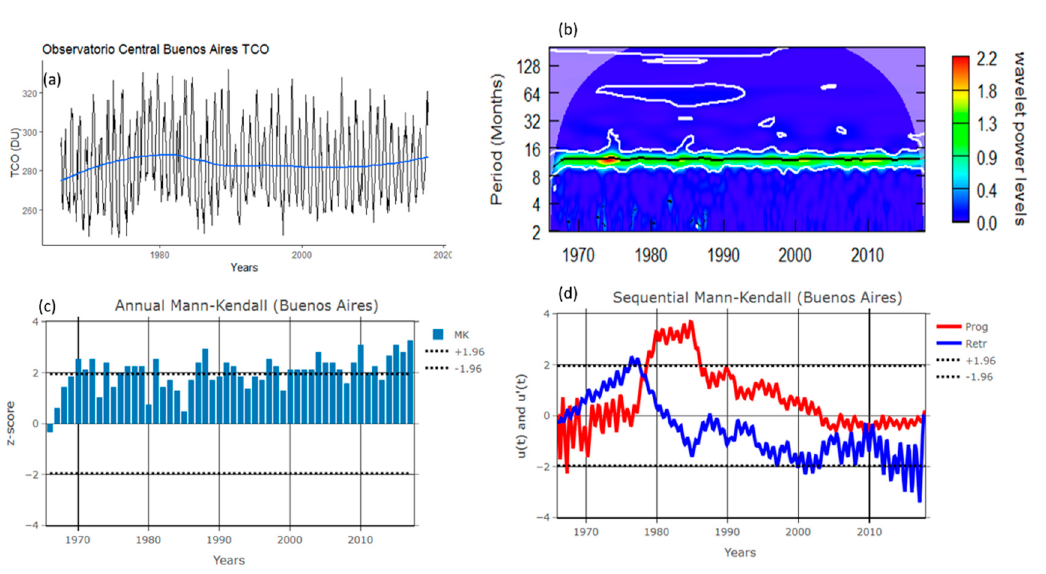
Figure 8. OCBA TCO time series with its smooth trend ( a ), normalized wavelet power spectra of the TCO data ( b ), annual mean Mann-Kendall calculated for TCO ( c ), and sequential Mann-Kendall statistics values ( d ).